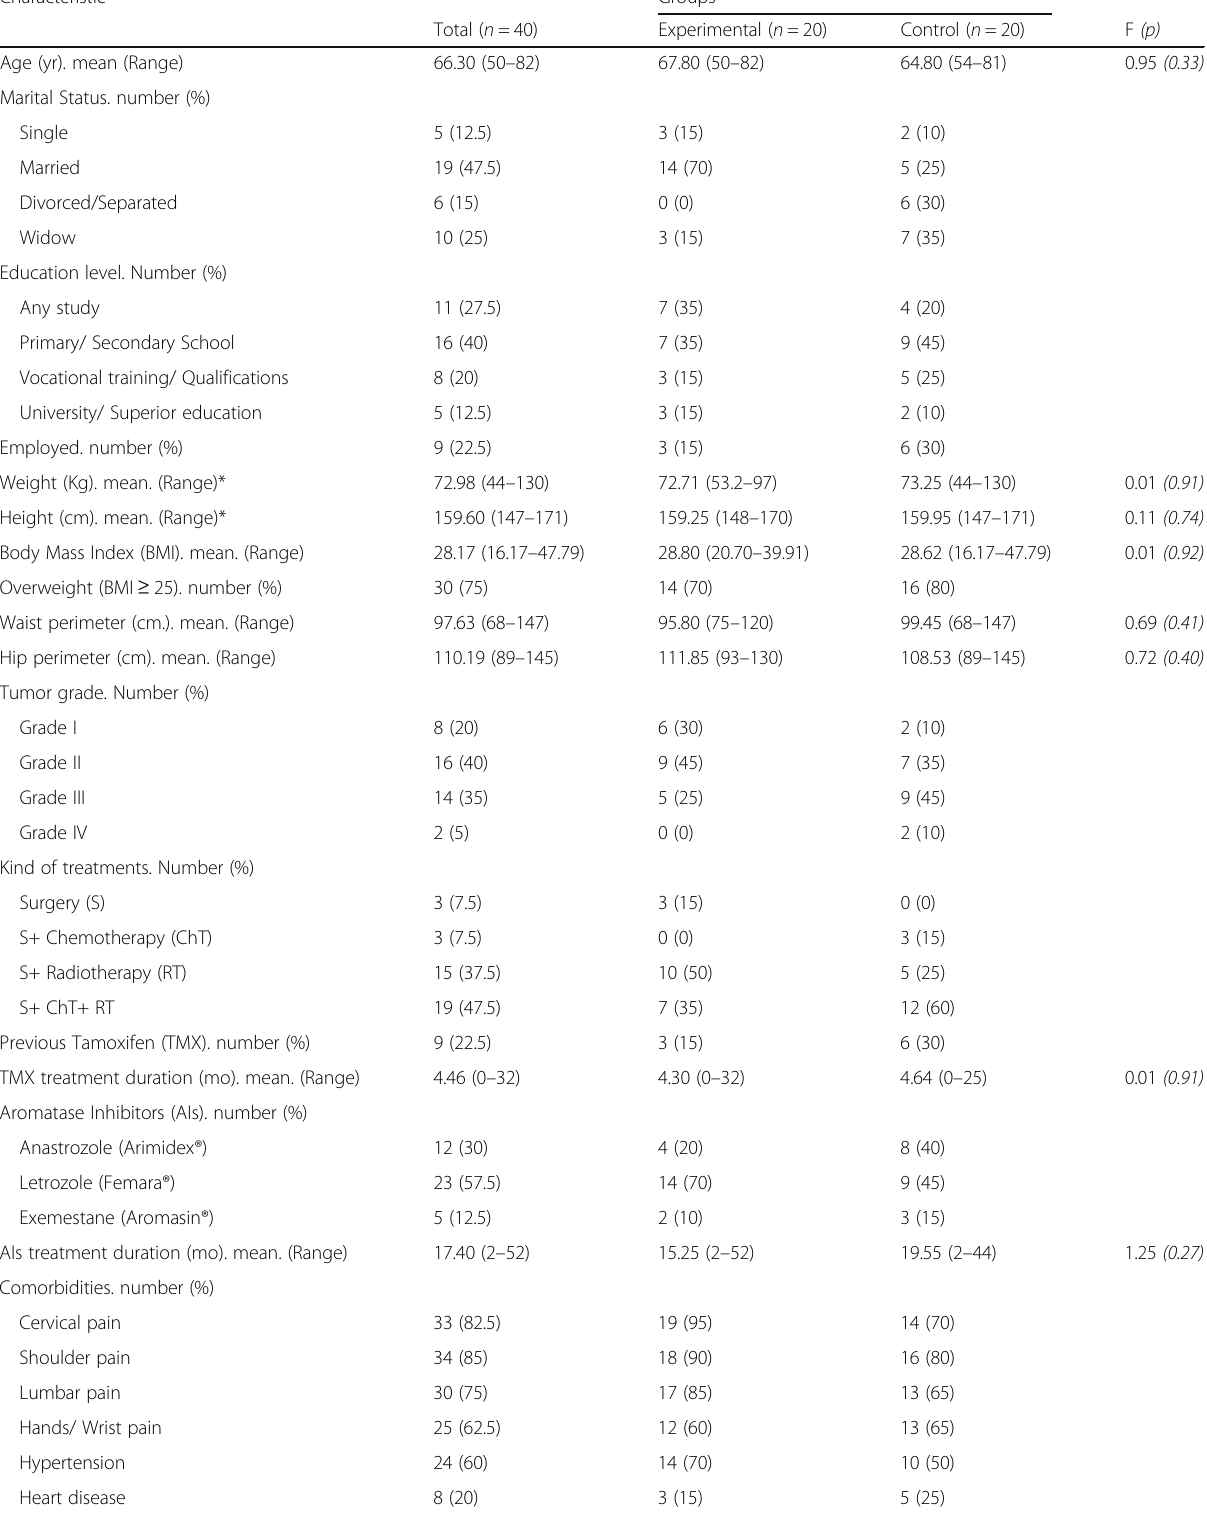
Table 1 Mean or number (%). Range (Min-Max) and ANOVA of demographic and clinical baseline characteristics of groups